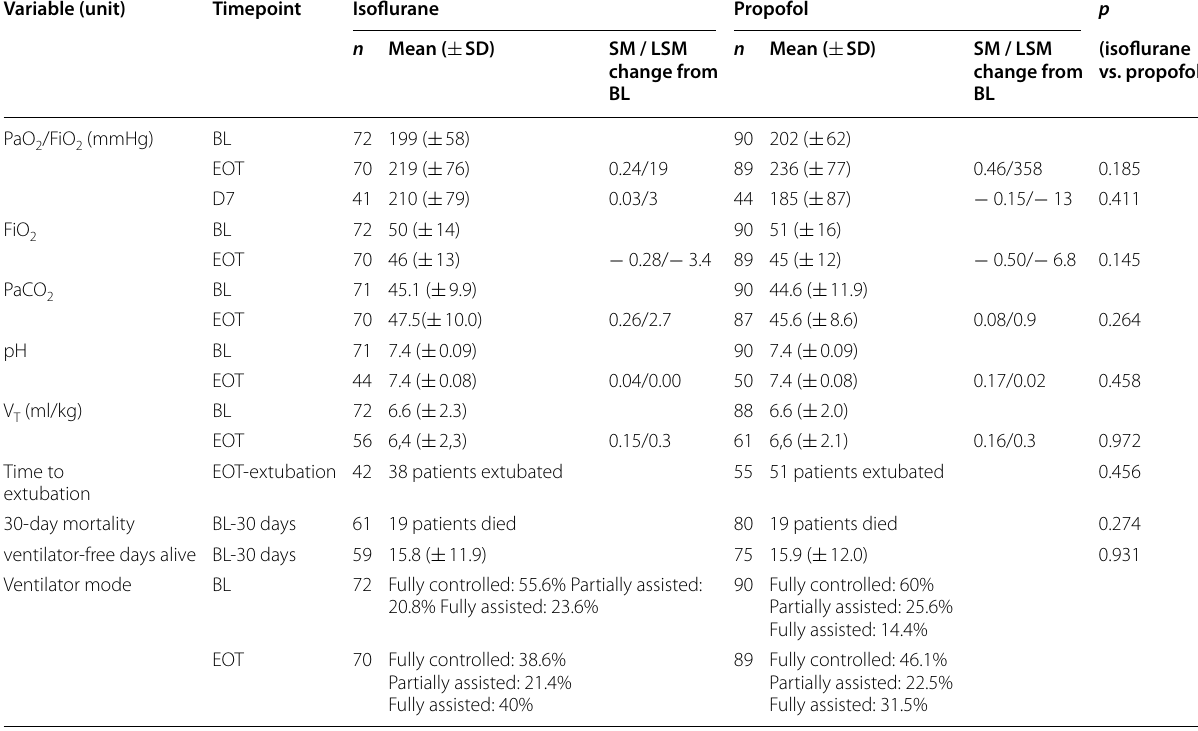
Change in PaO 2 /FiO 2 ratio between baseline (BL) and end of study sedation (EOT, usually after 48 h) LSM least squares mean, SD standard deviation, PaO 2 arterial partial pressure of oxygen, FiO 2 inspired fraction of oxygen, PaCO 2 arterial partial pressure of carbon dioxide. D7 day seven after randomization. SM standardized means mean divided by total pooled standard deviation. V T tidal